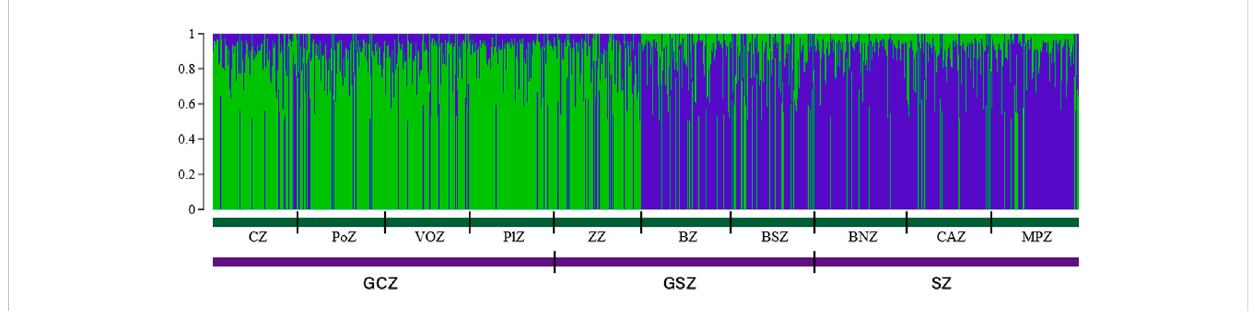
FIGURE 1 Goat population structure determined by STRUCTURE 2.3. Estimated histogram of the population structure with two ancestral populations ( K = 2). Each vertical bar represents one individual in the population based on the percentage of group membership, into the 2 inferred